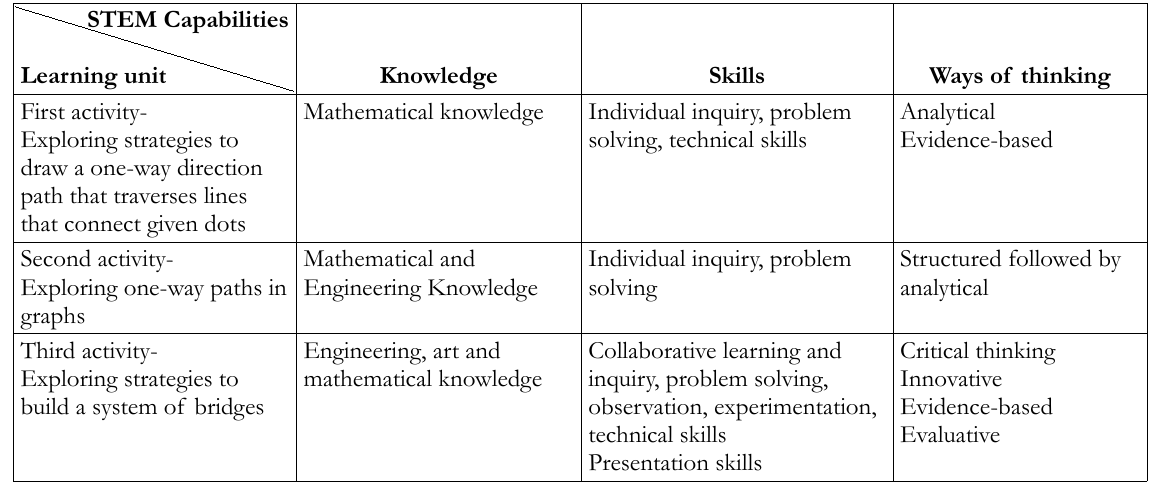
Table 3. The “Konigsberg bridge” activitie’’ analysis